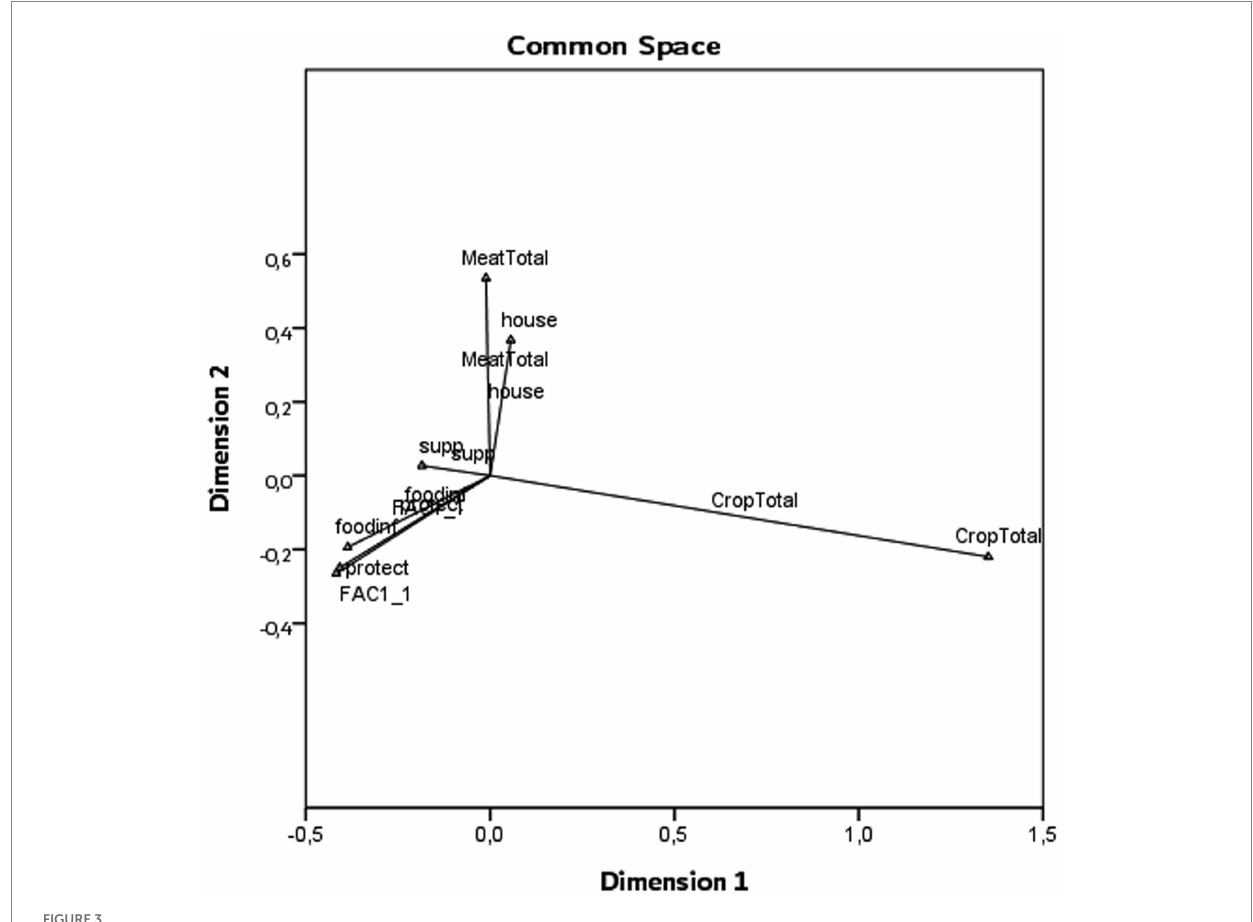
FIGURE 3 Variables in common space and Euclidean distances.